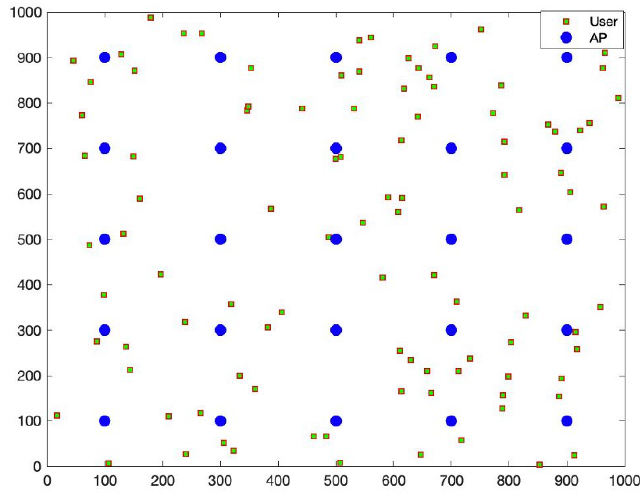
Figure 6. Network topology